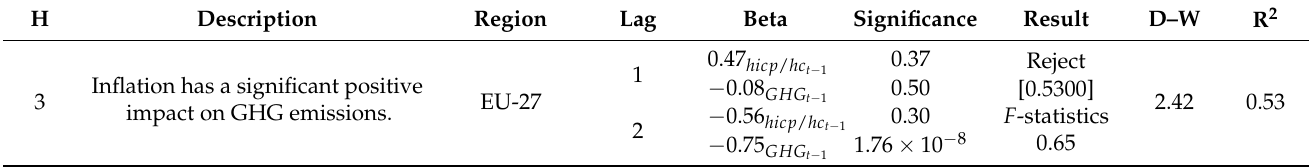
Table 6. Testing Hypothesis